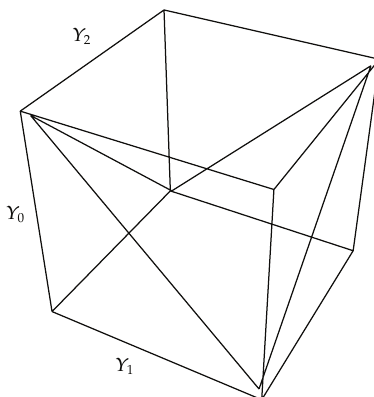
Figure 4: Polygon corresponding to the scattering of four gluons.